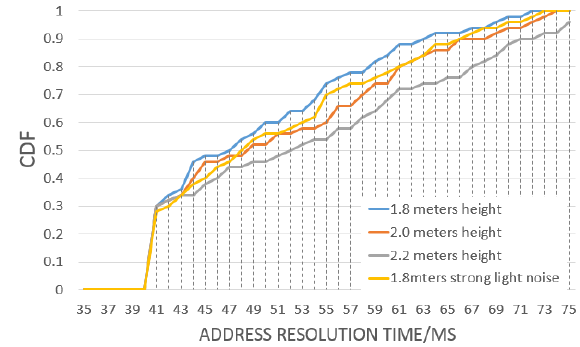
Figure 9. Edge region location time & resolution success rate